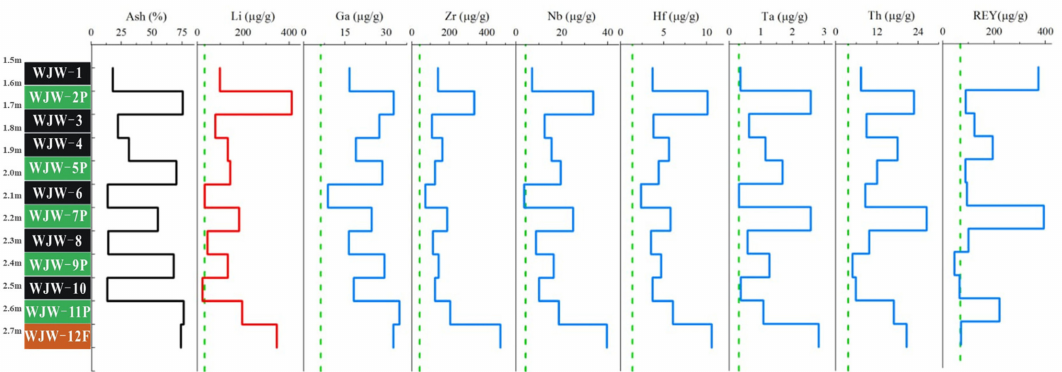
Figure 9. Concentration variations of ash yield and enriched elements (Li, Ga, Zr, Nb, Hf, Ta, Th, and REY) in the No. 5 Coals from the Wujiawan mine. The green dotted lines represent the average value of each element for world hard coals